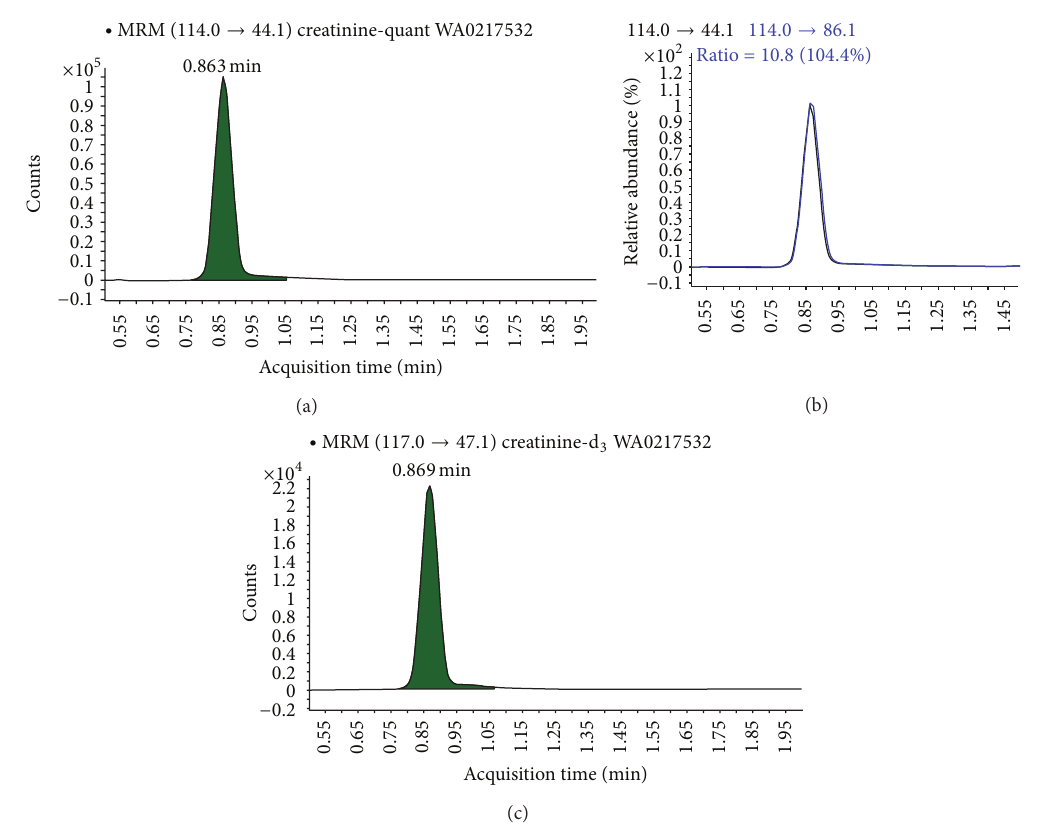
Figure 1: Chromatogram of a WEBS participant urine sample showing the transition ions for creatinine and creatinine-d 3 : 114.0 to 44.1 (quantifier; (a)), 114.0 to 86.1 (qualifier; (b)), and 117.0 to 47.1 (creatinine-d 3 ;